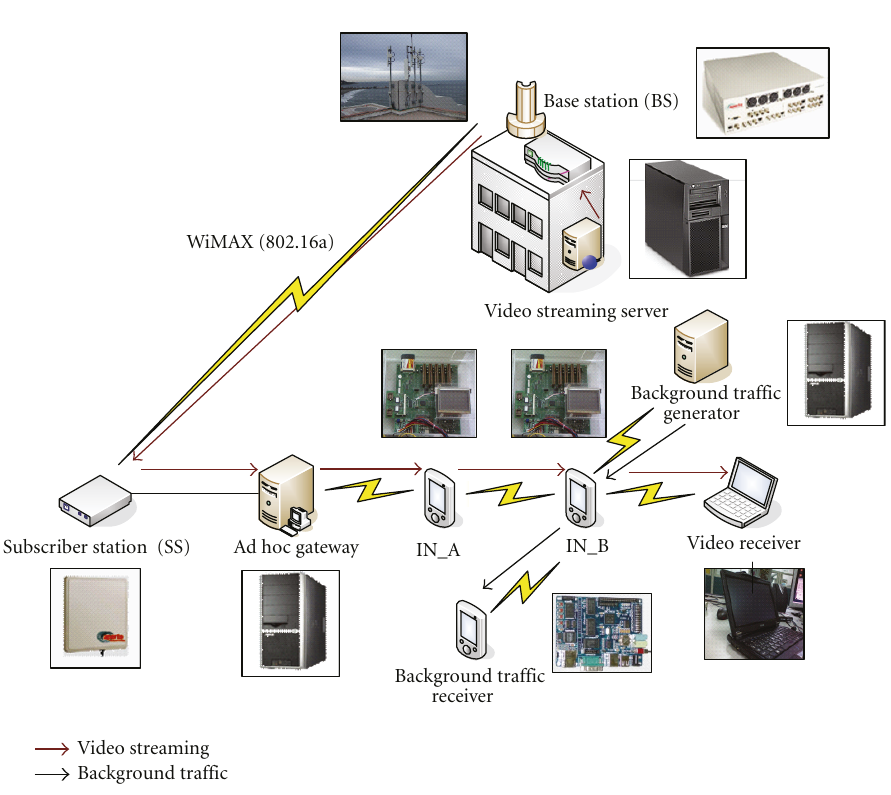
Figure 5: Implementations of I-EPD on a Linux